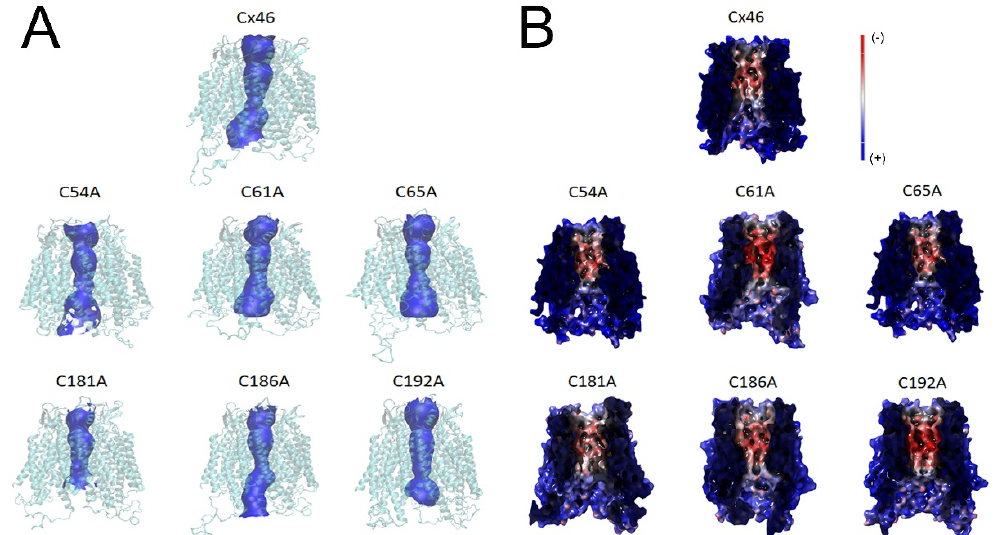
Figure 5. MD simulations suggest discreet changes in both pore size and electrostatic potential in hemichannels formed by Cys mutants. Human Cx46 50 ns MD models. ( A ) Hemichannel tertiary structure is shown in light blue, while the pore profile is shown in blue. ( B ) Electrostatic potential of the hemichannel pore with negative and positive potentials represented in red and blue colors, respectively. Note that small red changes are observed in all the mutants, which were more evident in C61A and C192A.